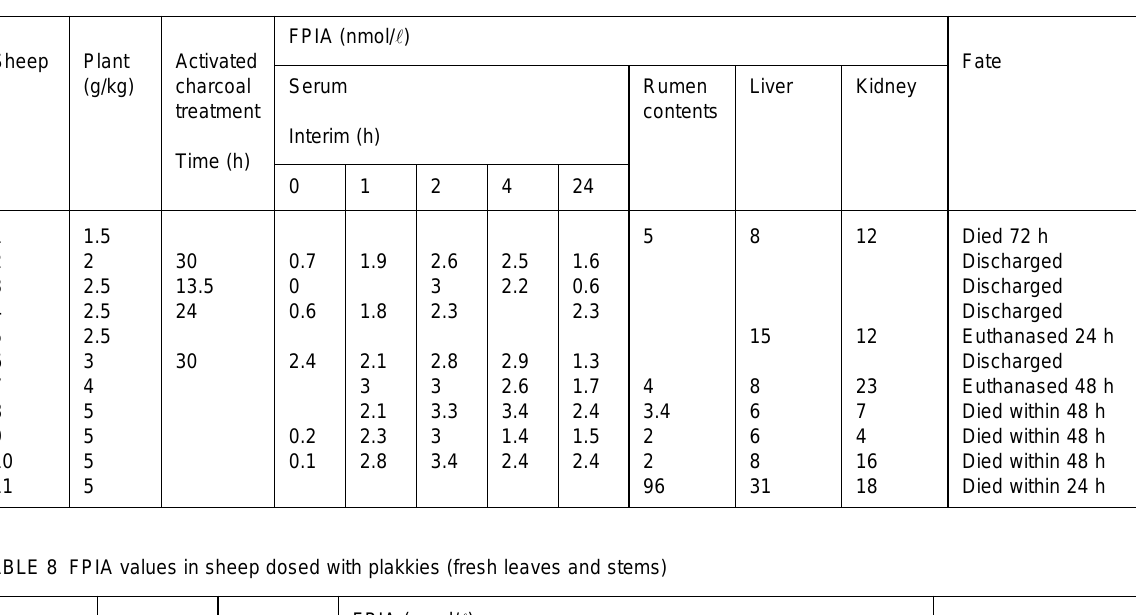
TABLE 7 FPIA in sheep dosed with fresh slangkop ( D. sanguinea)